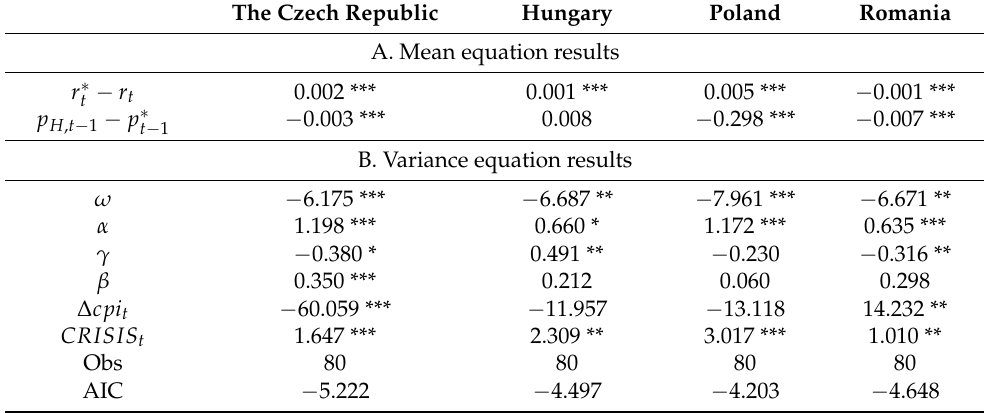
Table 3. Univariate EGARCH results (baseline